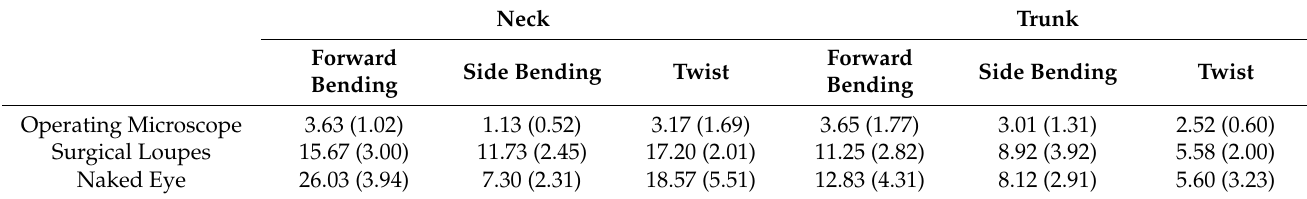
Table 1. Rotation angles for neck and trunk: the first number is the average value in degrees while the second one inside parentheses is the standard deviation (also in